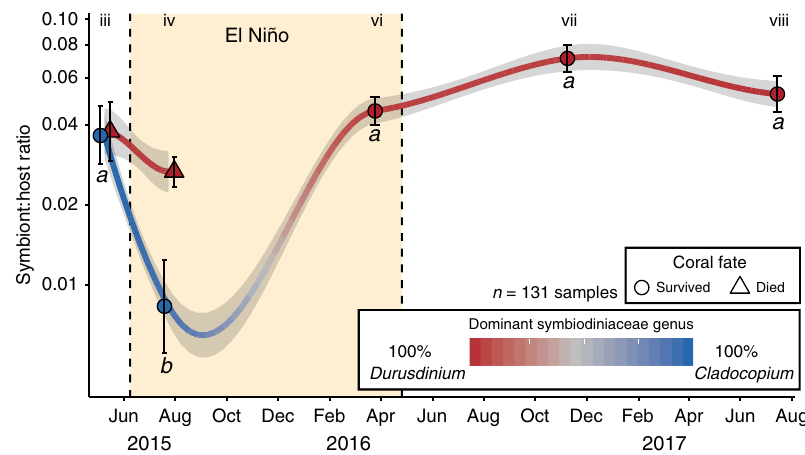
Fig. 4 Changes in Symbiodiniaceae abundance and identity during the 2015 – 2016 El Niño. Mean symbiont:host cell ratios (±s.e.) at time points spanning from before to >1 year after the El Niño event for tracked Platygyra ryukyuensis coral colonies that survived (circles) or died (triangles). Sample size refers to the total number of measurements across all time points. Bleaching is indicated by a low cell ratio density (e.g., 0.01). Fitted lines show potential trajectories between sampled time points, and color (blue vs. red) indicates dominant Symbiodiniaceae genus in tracked colonies. The shaded pale yellow area between dashed vertical lines corresponds to >4 degree heating weeks from Fig. 2. Letters indicate signi fi cant differences between means for colonies that survived. Symbiont:host ratios were not signi fi cantly different across the two 2015 expeditions for colonies that died.